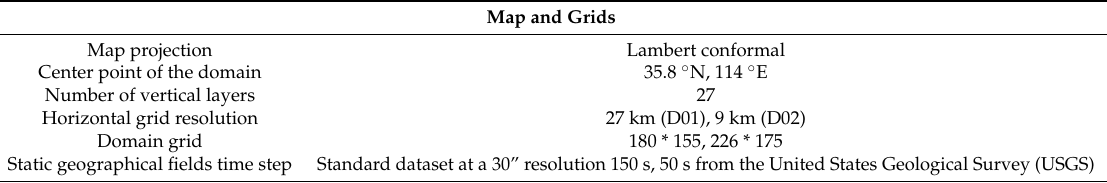
Table 1. The main configuration of the Weather Research and Forecasting (WRF)